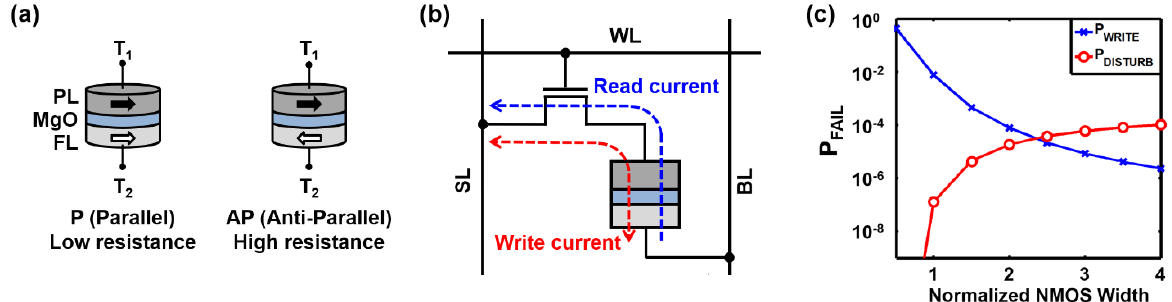
Figure 1. ( a ) Magnetic tunnel junction (MTJ) device structure; ( b ) read and write current paths of spin-transfer torque magnetic random-access memory (STT-MRAM); ( c ) probability of write failure and probability of disturb failure with respect to a range of access transistor width [8].